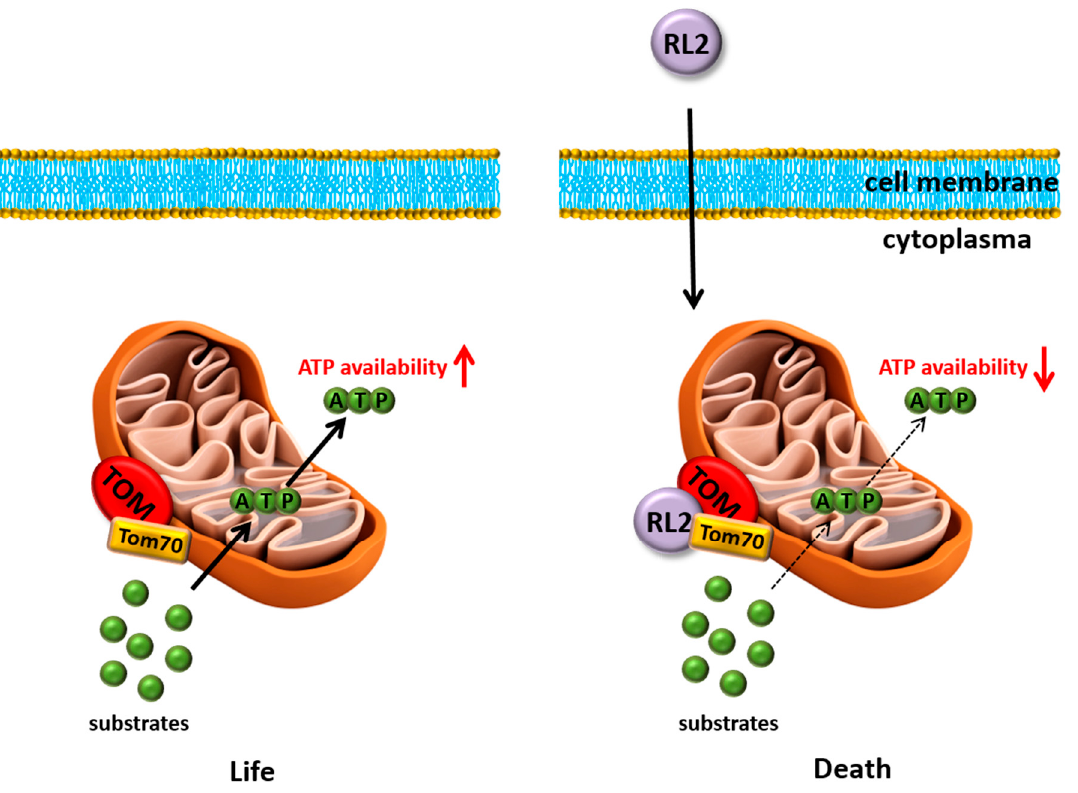
Figure 8. RL2-mediated cell death pathways. RL2 translocates into the cytosol and localizes at the mitochondrial membrane by interaction with TOM70. This interaction leads to a drop of mitochondrial membrane potential and reduces ATP production. The latter might be due to the impairment of the TOM complex function, which is required for the transport of the substrates for ATP synthesis or conformational changes at the outer mitochondrial membrane caused by RL2–TOM70 interaction. The reduced ATP levels lead to cell death.